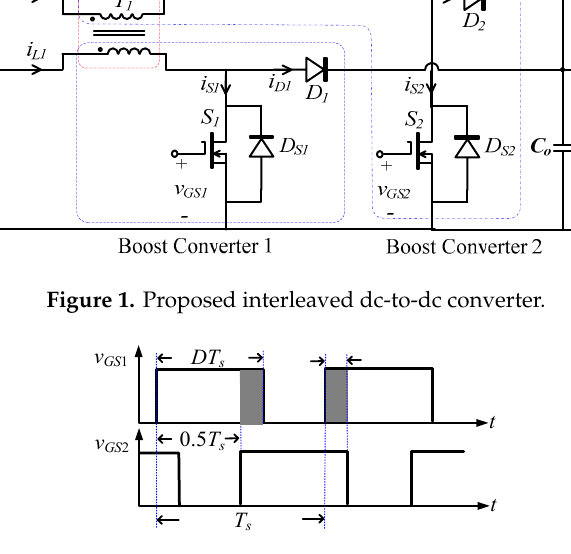
Figure 2. Gate-source voltages v GS 1 and v GS 2 .